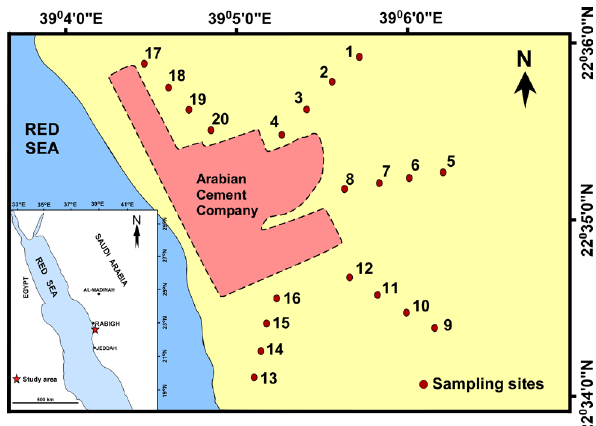
Figure 1: Map showing the study area and sampling sites around the cement